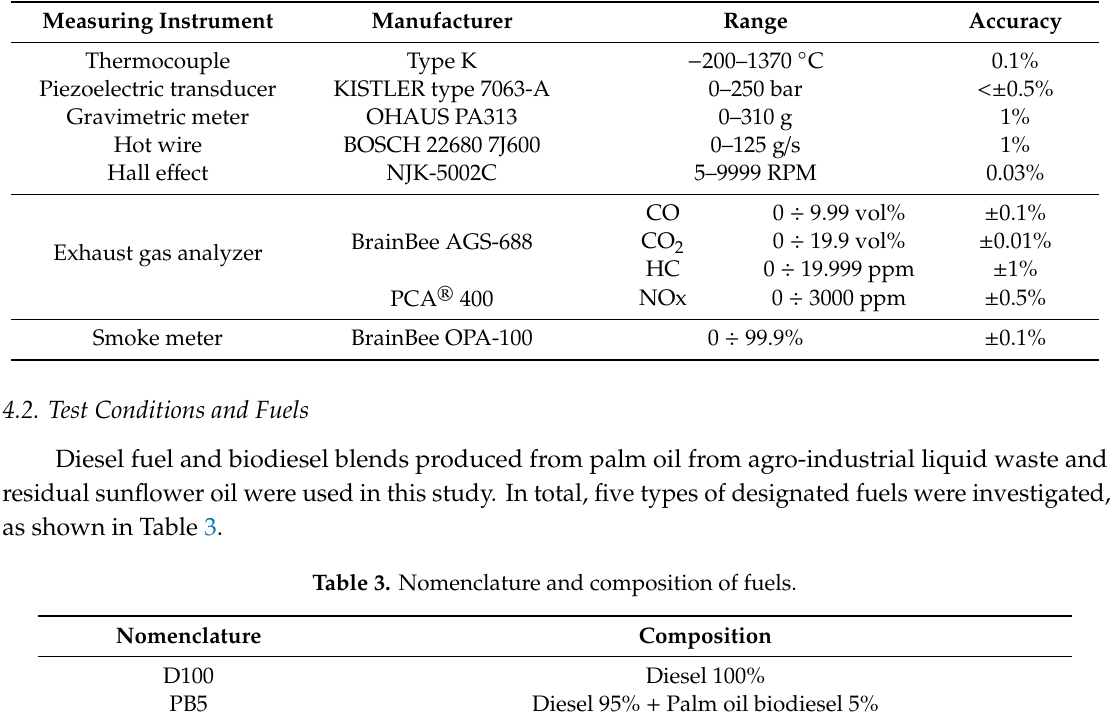
Table 2. Specifications of measuring instruments.